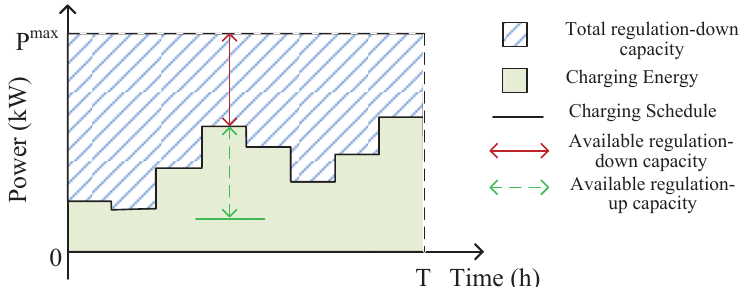
Figure 2. The relationship between the charging energy and total regulation capacity during the charging period.